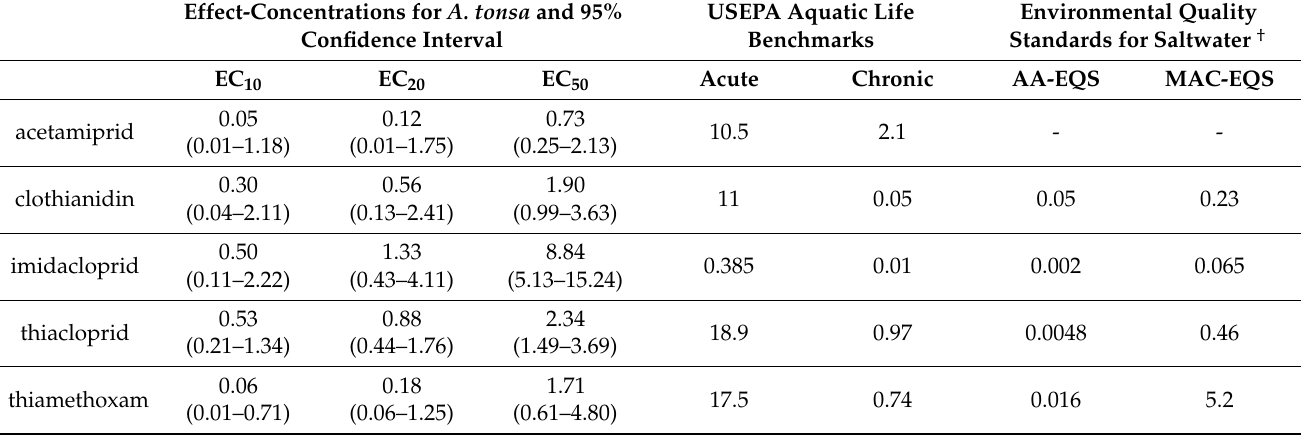
Table 2. Summary of the effect concentrations calculated for the NEOs. Data are expressed in µ g L − 1 . US Environmental Protection Agency (USEPA) Office of Pesticide Programs (OPP) aquatic life benchmarks were retrieved from https://www.epa.gov/pesticide-science-and-assessing-pesticide- risks/aquatic-life-benchmarks-and-ecological-risk, accessed on 2 June 2021. Environmental quality standards for saltwater were retrieved from Moeris et al.